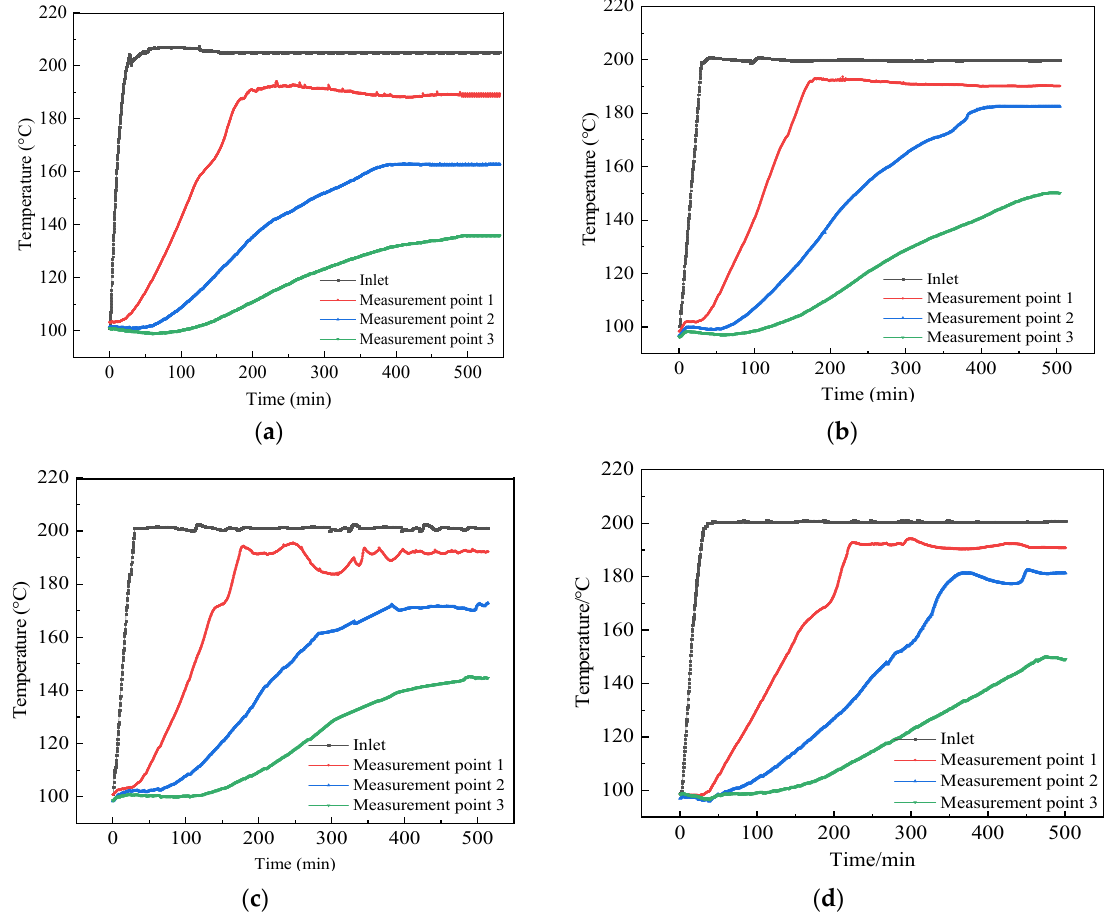
Figure 8. Temperature variation at temperature measurement points under different flooding modes: ( a ) pure steam flooding, ( b ) N 2 + steam flooding, ( c ) CO 2 + steam flooding, and ( d ) flue gas + steam flooding. The stable temperature of each temperature measurement point under different dis- placement modes is shown in Figure 9 and Table 4. In pure steam flooding, the end temperature of the model was 135.9 ◦ C, while it increased by 14.3 ◦ C, 8.8 ◦ C, and 13.1 ◦ C